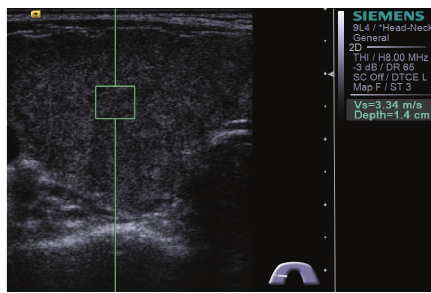
Figure 1: Image showing how measurements of shear wave velocity in thyroid were made. The 5 × 5mm region of interest is entirely enclosed within the thyroid